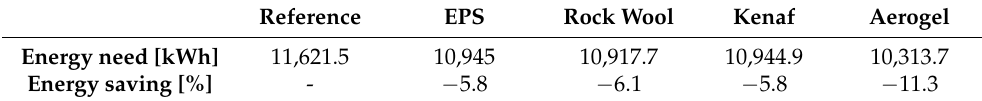
Table 7. Data on the Energy Need and Energy Saving of Insulated Buildings Compared with the Reference.